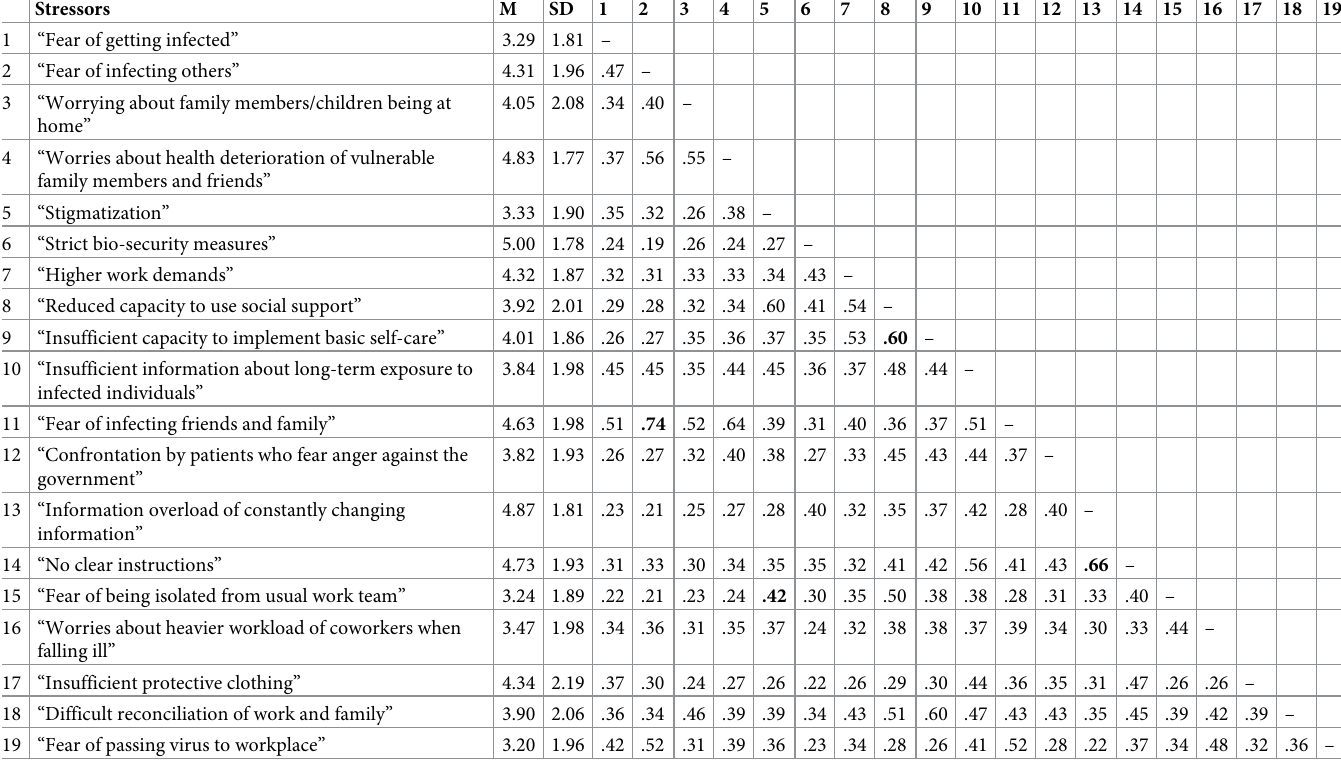
Table 1. Means, standard deviations and bivariate correlations of different